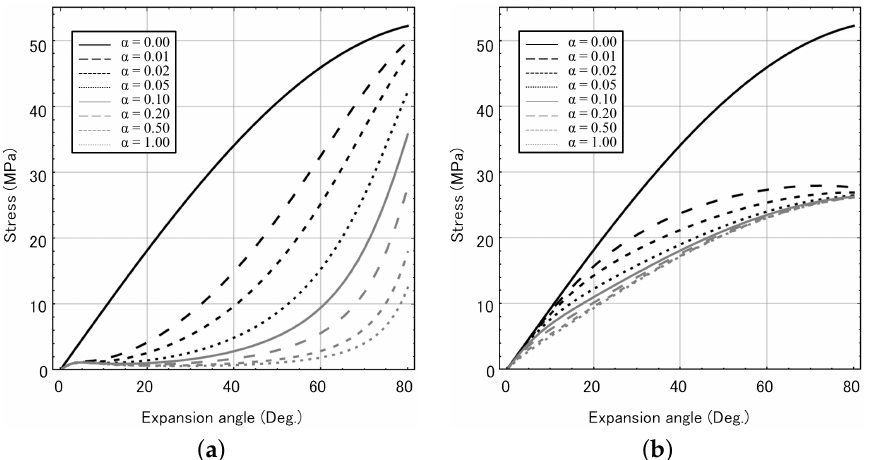
Figure 4. Relationship between the bending stress and expansion angle θ : ( a ) model with upper horizontal strut member; ( b ) model with right vertical strut